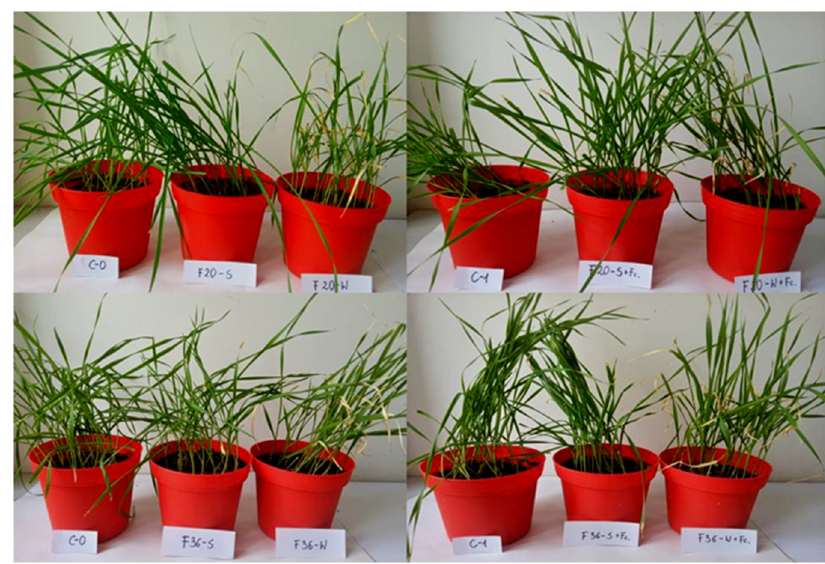
Figure 2. Phytotoxicity symptoms in wheat seedlings after 2actpTS and JTS application. Table 1. Phytotoxicity, plant biomass, and disease index of wheat ( Triticum aestivum L.) seedlings after 2actpTS and JTS